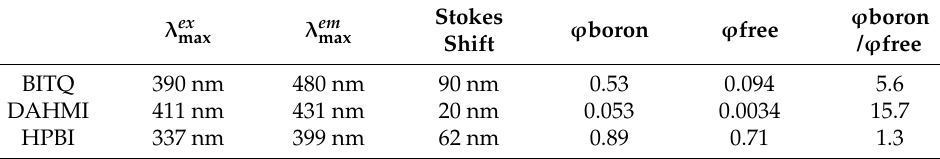
Table 1. Fluorescence properties of tested compounds.